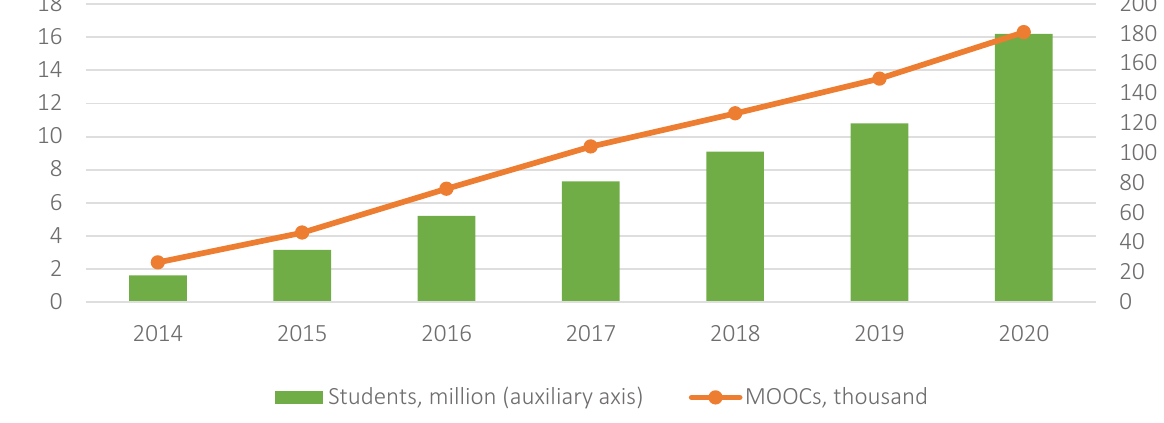
Figure 6. Dynamics of the courses MOOC and students (attendees), 2014–2020